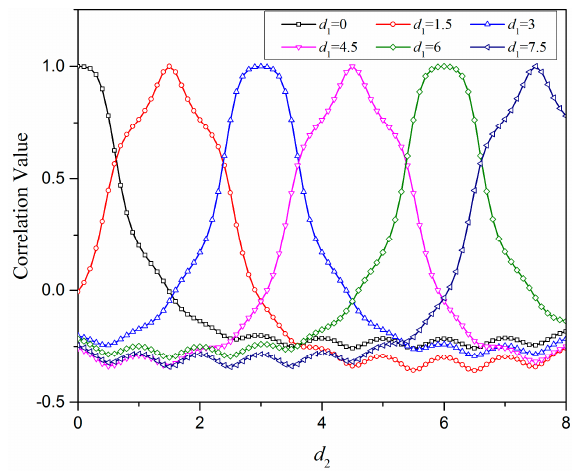
Figure 5. The relationships between the correlation values and the relative distances of two force loads both with variable locations when the sensor number n is set as 9 and the spacing parameter s is set as